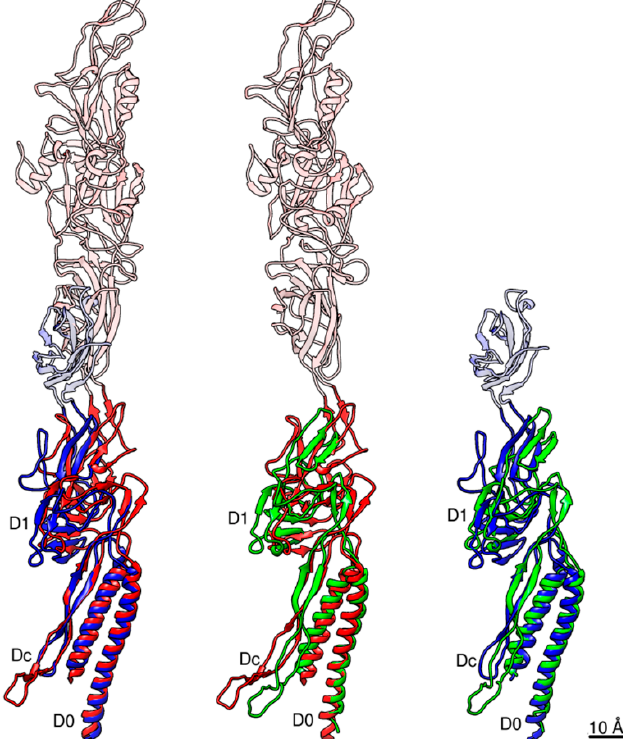
Figure 5. Pairwise structural comparison between Salmonella FlgE and FlgG and Campylobacter FlgE. Salmonella FlgE and Campylobacter FlgE are compared in the left panel, Salmonella FlgG and Campylobacter FlgE in the middle, and Salmonella FlgE and FlgG in the right. The C α ribbon models are colored only for domains D0-Dc and D1, with Salmonella FlgE in blue, FlgG in green and Campylobacter FlgE in red. Domain D0 is used to superpose these molecules. The relative arrangements of domains D1 and D0-Dc between these three molecules are slightly different to one another as shown in this figure. The extra part of domain D1 present in FlgE and missing in FlgG is the triangular loop involved in the intersubunit sliding interactions between D1 and D2 along the protofilament for its compression and extension.